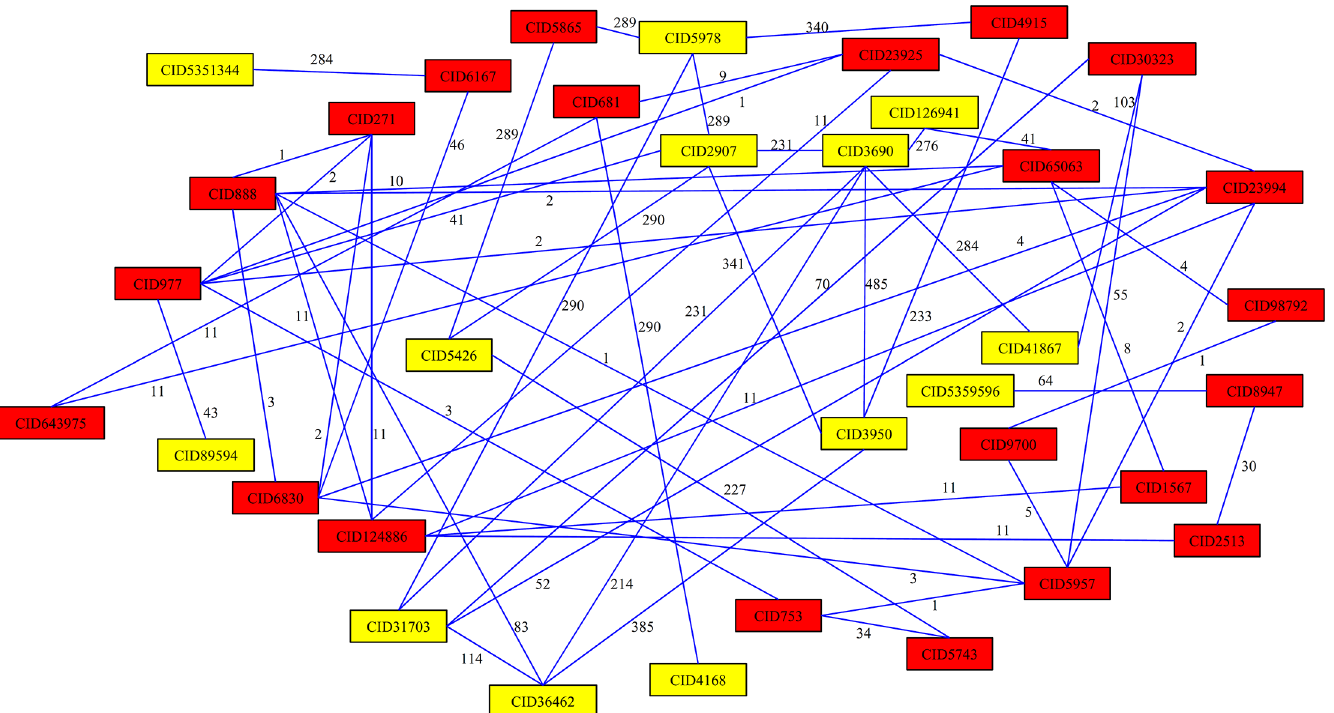
Fig 2. 78 shortest paths connecting 13 SCLC-related chemicals, which were obtained by applying Dijkstra ’ s algorithm in the constructed network. Yellow rectangles represent 13 NSCLC-related chemicals, and red rectangles represent 22 other chemicals involved in these 78 shortest paths. Numbers on edges represent edge weights in the